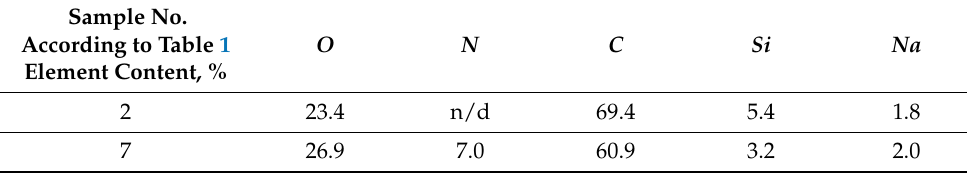
Table 2. Analysis data of X-ray photoelectron spectra. Sample